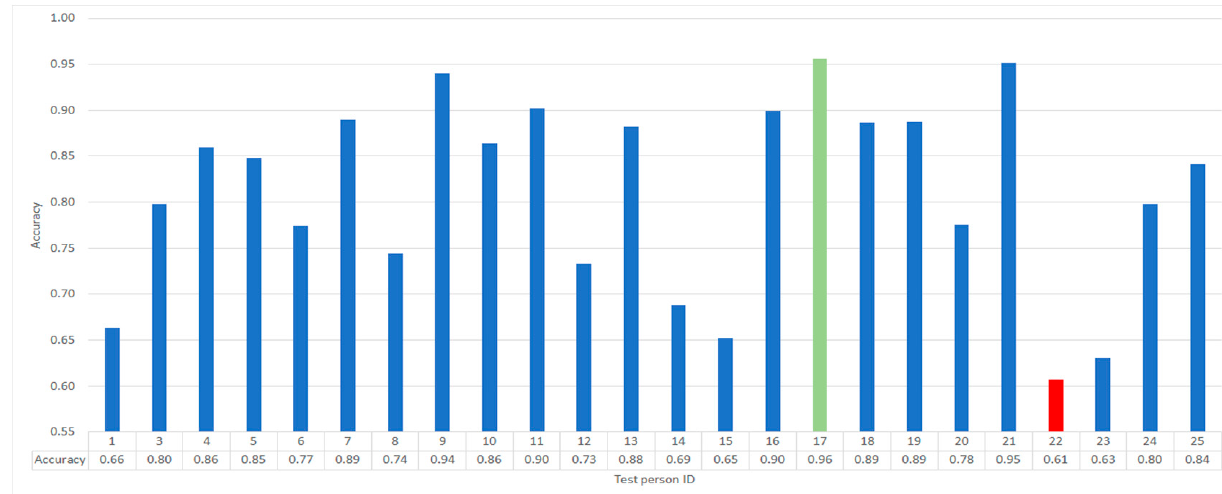
Figure 11. The results of cross validation with a leave-one-out approach. The classifier separates L0 and L3 in the 1.5 days of training data condition. Subject 2 was removed during the initial data preparation stage due to insufficient data quality. The average score was 81.1% and all subjects achieved accuracy above chance level.